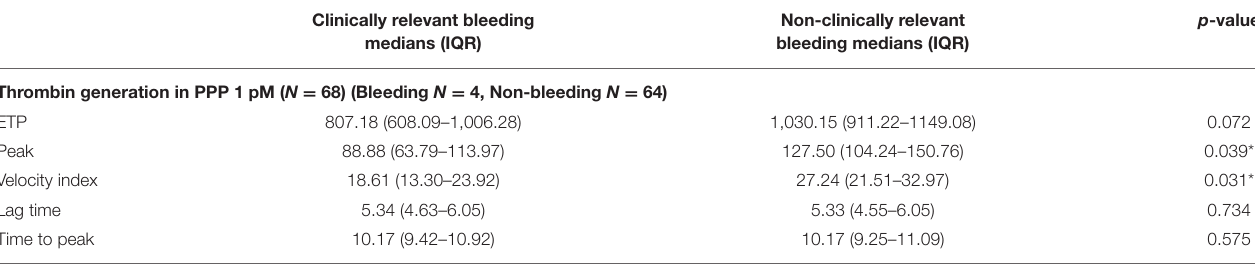
TABLE 2 | Thrombin generation 6 months after PCI in PPP for patients with and without clinically relevant bleeding during follow-up (recorded at T3).